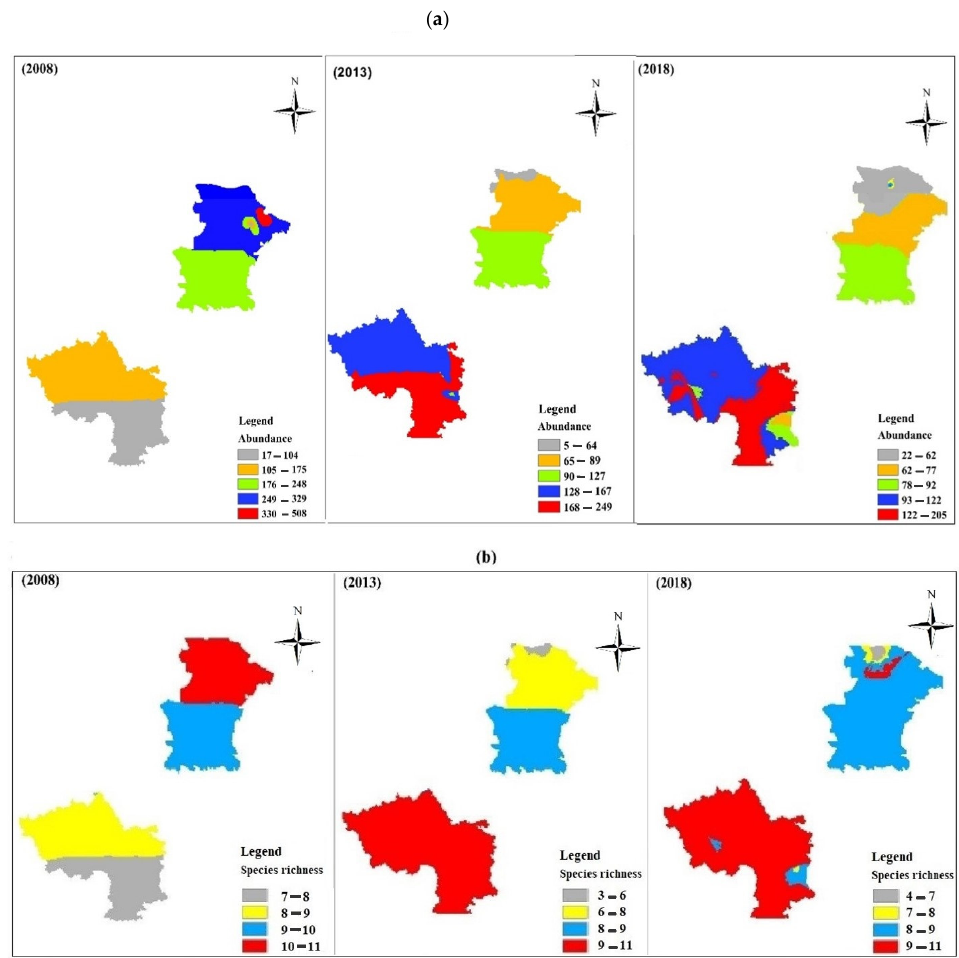
Figure 5. Map of carabid beetle study areas showing ( a ) abundance and ( b ) species richness per survey at five-year intervals.